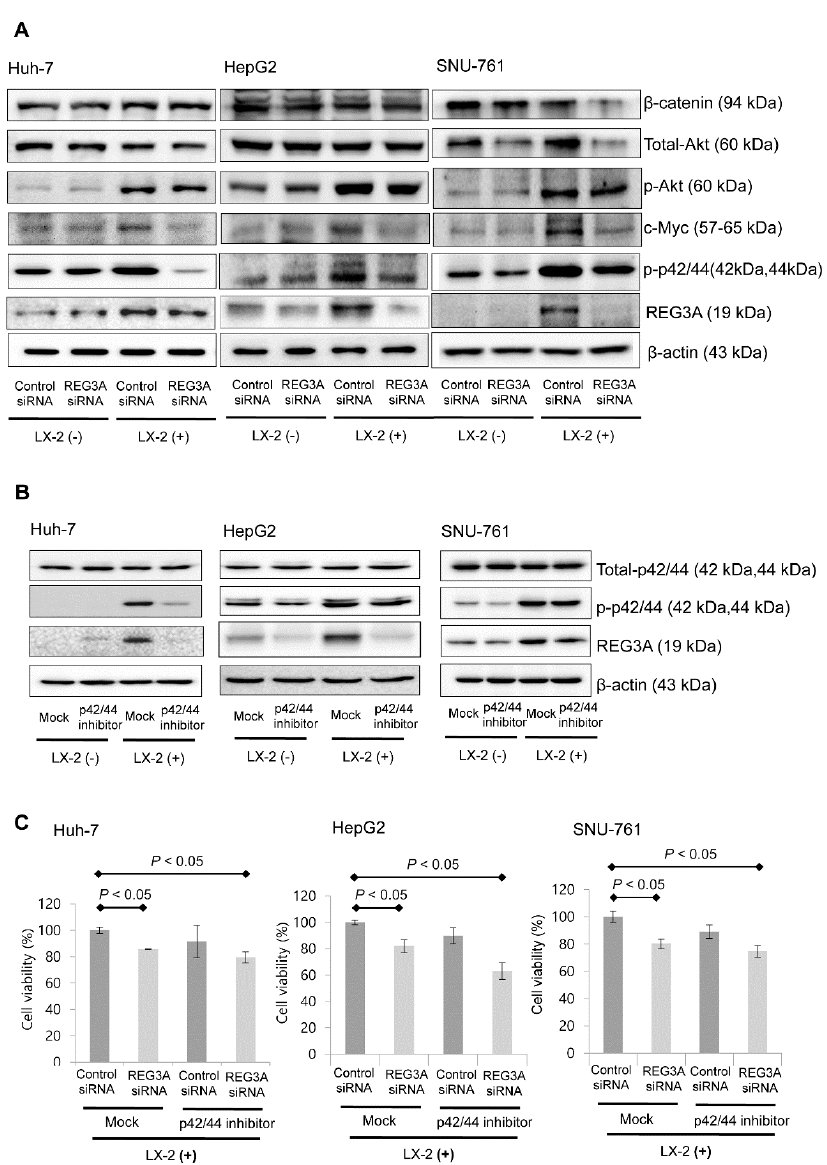
Figure 4. The p42/44 pathway-dependent REG3A activation modulates the expression of platelet-derived growth factor ββ (PDGF- ββ ). ( A ) Immunoblot analyses of β -catenin, p-Akt, total Akt, c-myc, phosphorylated p42/44, total p42/44, and REG3A were performed in cocultured or monococultured HCC cells with REG3A siRNA or control siRNA transfection. The experiment was repeated three times. ( B ) P42/44 inhibitor (PD98059, 10 μ M) significantly decreased the protein expression of REG3A in cocultured HCC cells. The experiment was repeated three times. ( C ) Downregulating REG3A significantly suppressed HCC cell proliferation based on the MTT assay results ( p < 0.05). The experiment was repeated three times. The data are expressed as mean ± SD .